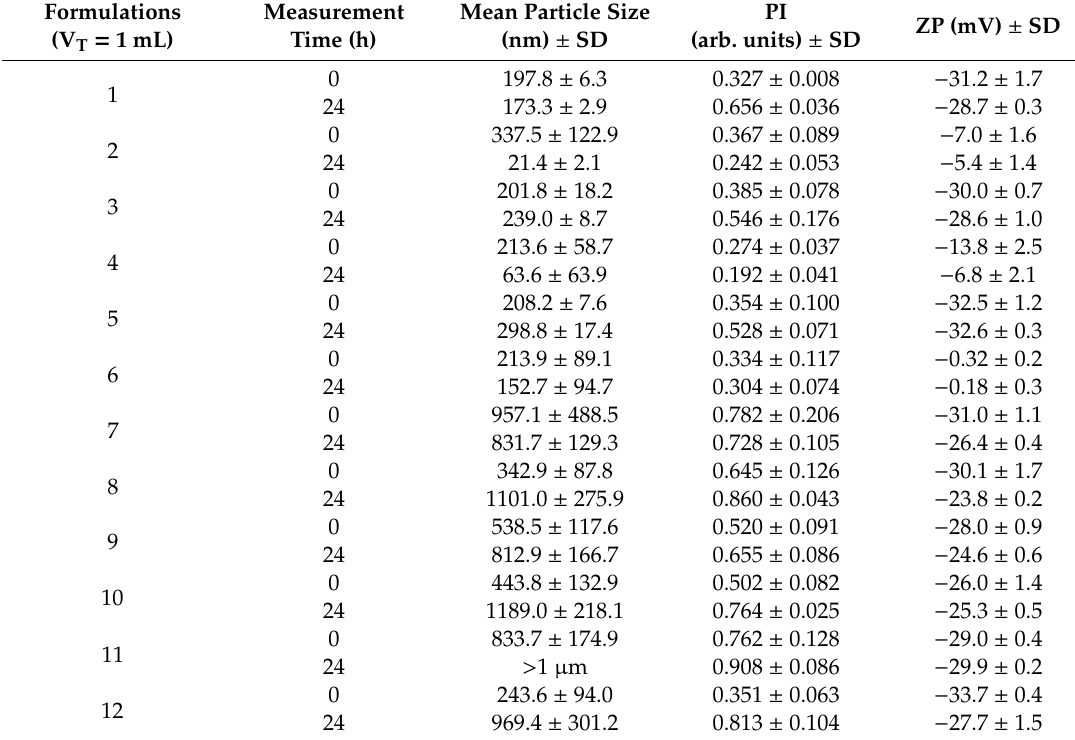
Table 5. Preliminary screening of surfactant based on the mean particle size, polydispersity index (PI) and zeta potential (ZP) of formulations without solid lipid (no. 1–6) and formulations with solid lipid (no. 7–12), measured immediately after production (0 h) and after 24 h stored at 4 ◦ C.